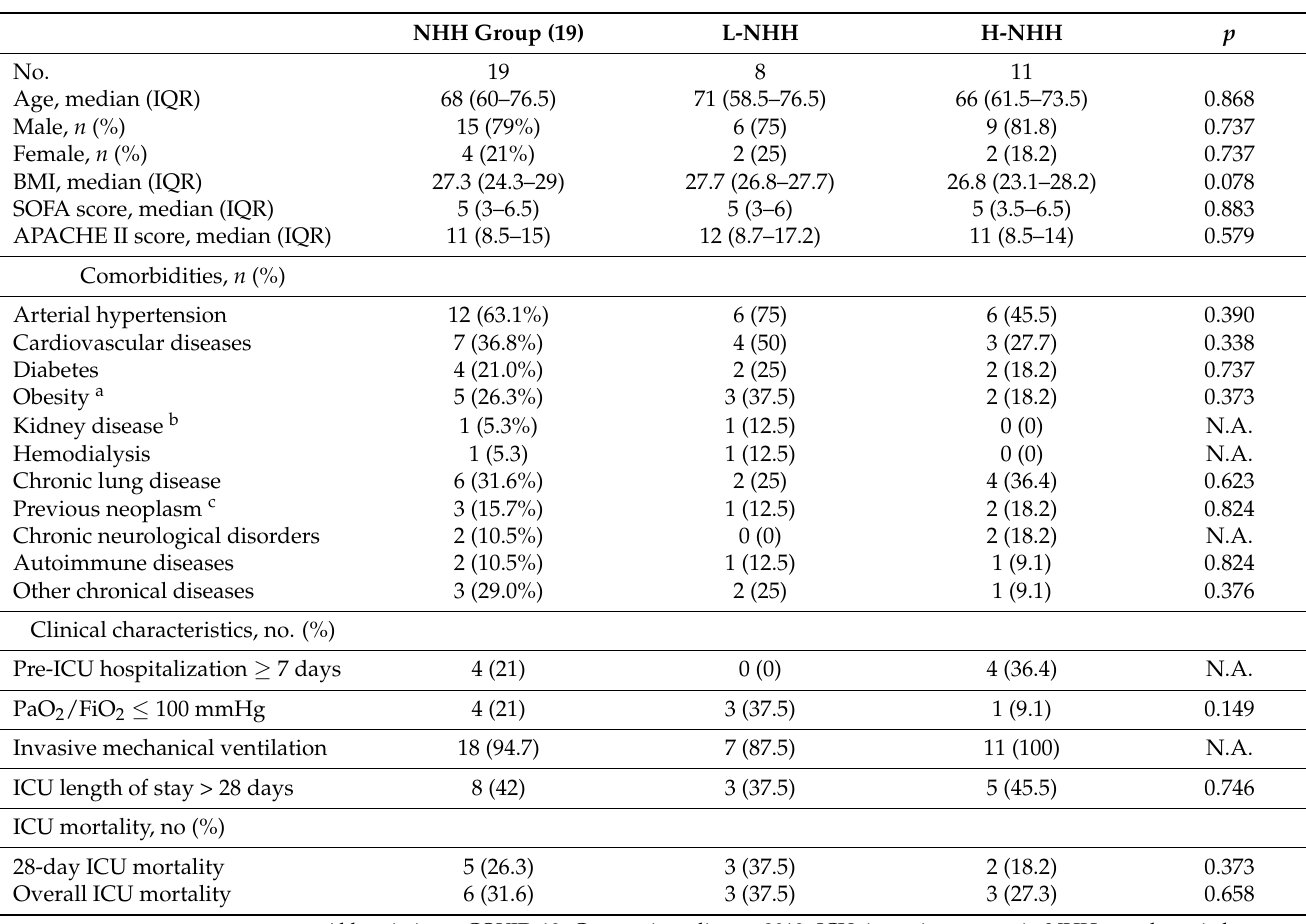
Table 3. Comparison between low-NHH and high-NHH in ICU COVID-19 patients. NHH Group